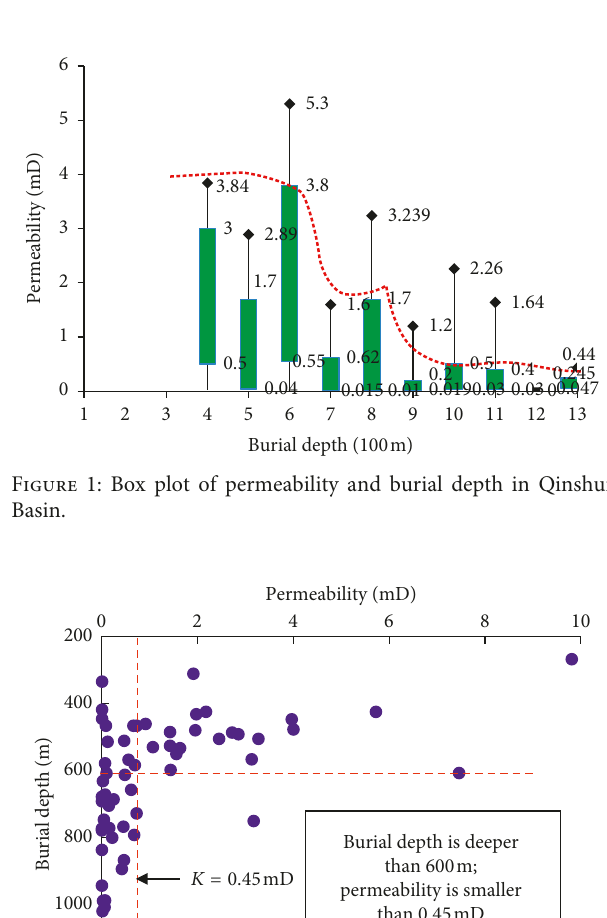
Figure 4: Relational graph of porosity and burial depth.